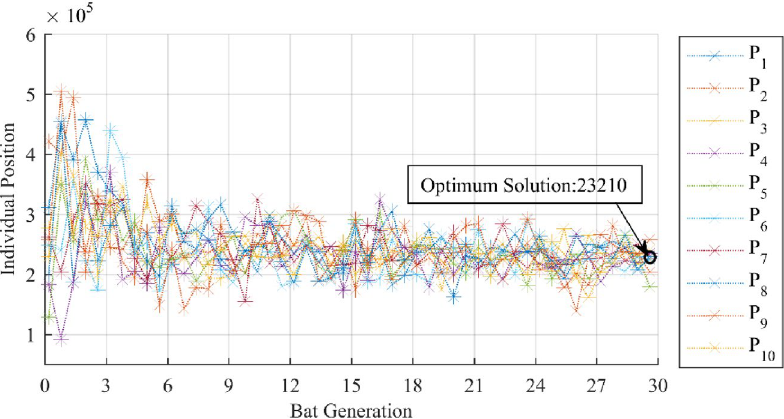
Figure 11. A complete search process of the bat colony. Obviously, the bats gradually converge to the best solution from the original scattered